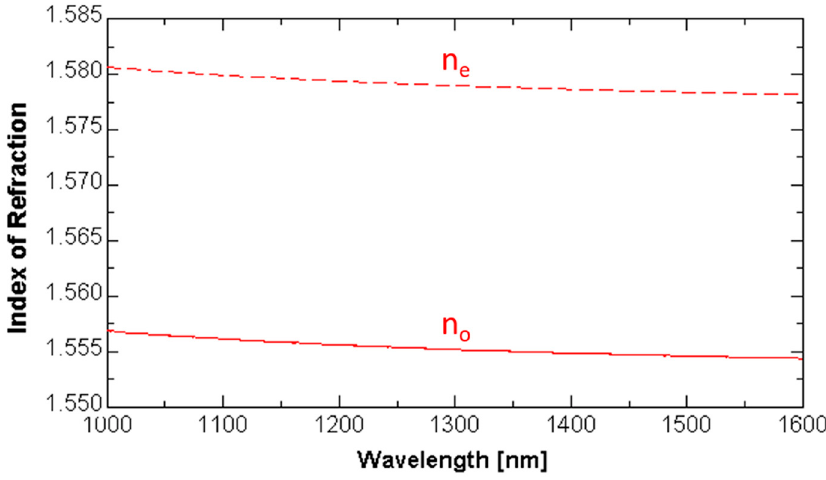
Figure 6. Ordinary (n o ) and extra-ordinary (n e ) refractive index curves of the deposited SiOC film extracted from measured ellipsometric data.